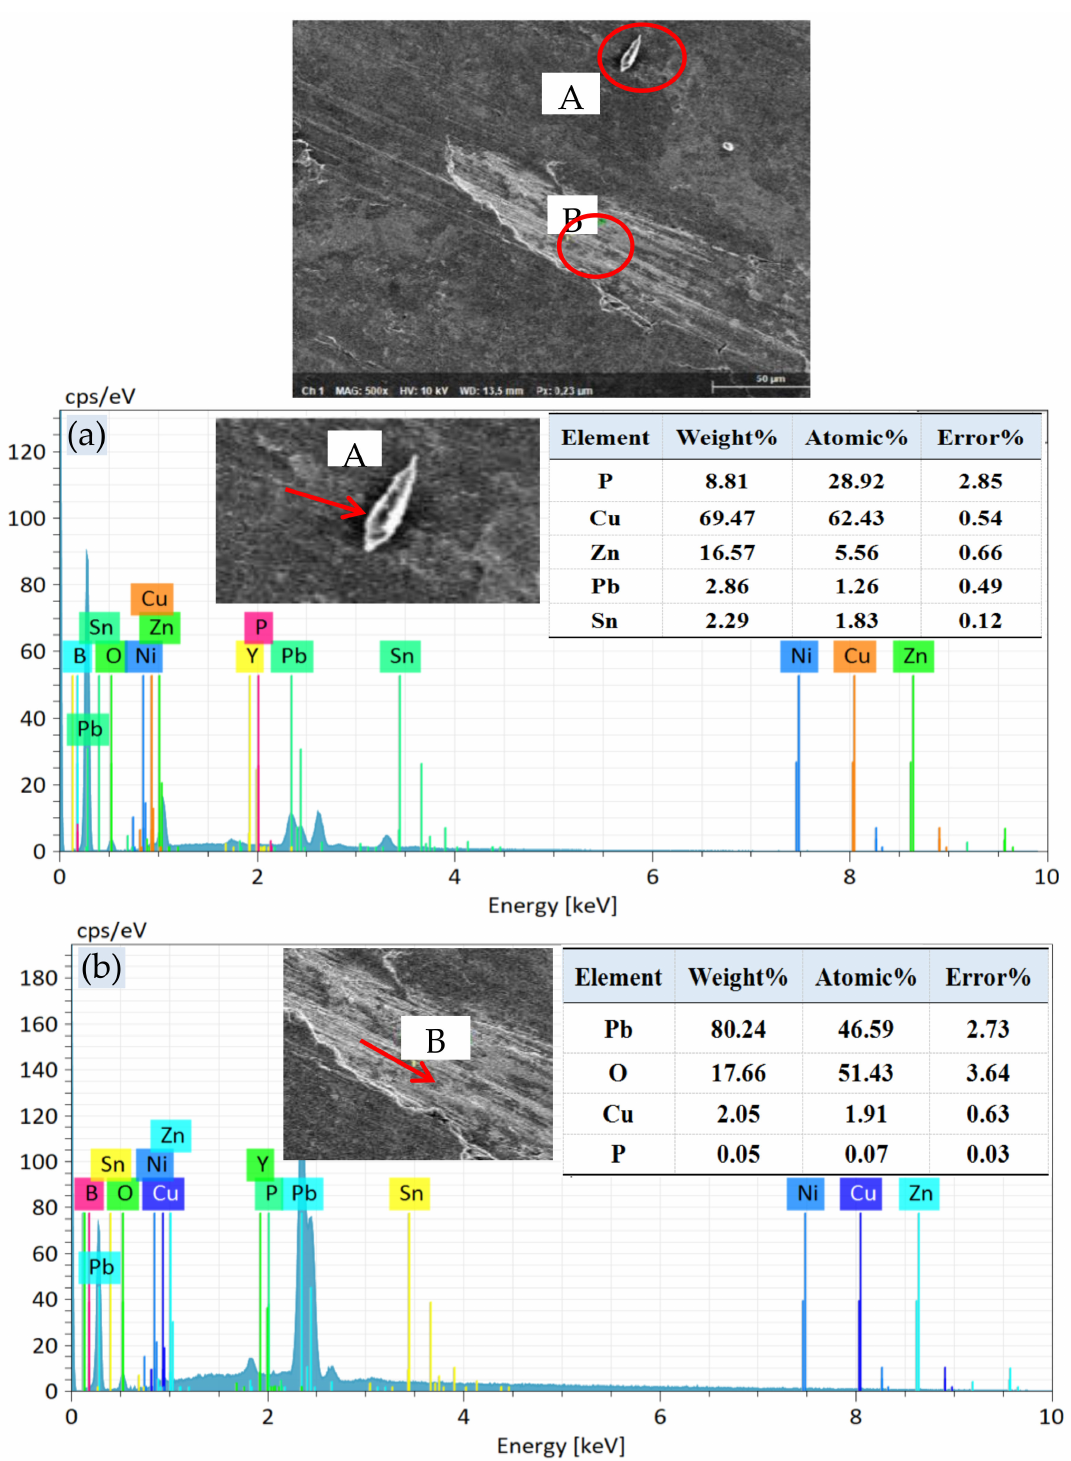
Figure 7. Analysis of friction topographies of ZCuPb 20 Sn 5 − 0.3 P : ( a ) EDS of A; ( b ) EDS of B. A